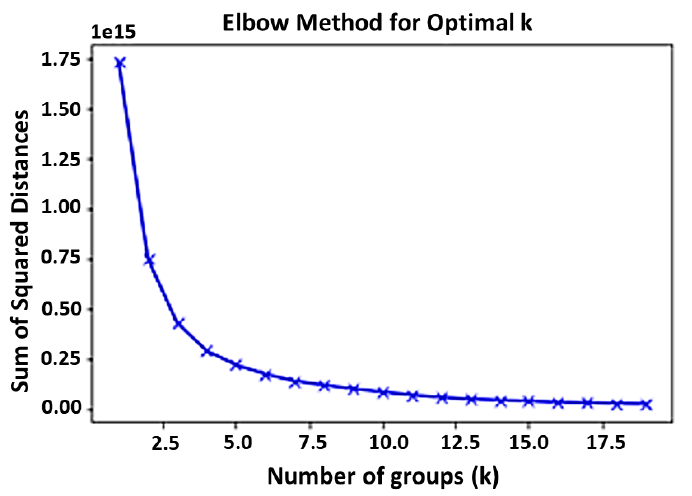
Figure A1. The elbow method to find the optimum cluster number points out k = 7 as the best number of features selected to represent collinearity.